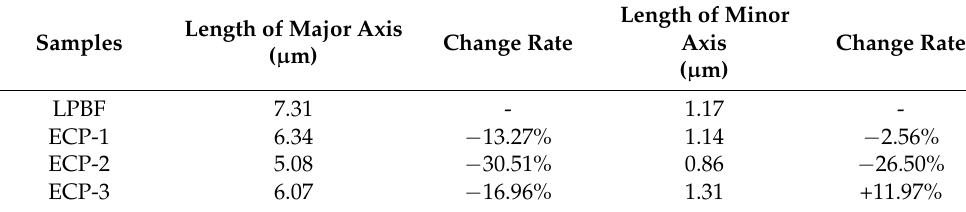
Figure 6. SEM-EBSD micrographs of the LPBF-Ti64 samples before and after ECP treatment where the α′ grains are in color according to its crystallographic orientation with respect to the Z0 axis (Z0 inverse pole figure (IPF) micrograph): ( a ) LPBF, ( b ) ECP-1, ( c ) ECP-2 and ( d ) ECP-3. Table 6. Size of α′ martensites in the LPBF-Ti64 samples before and after ECP treatment.